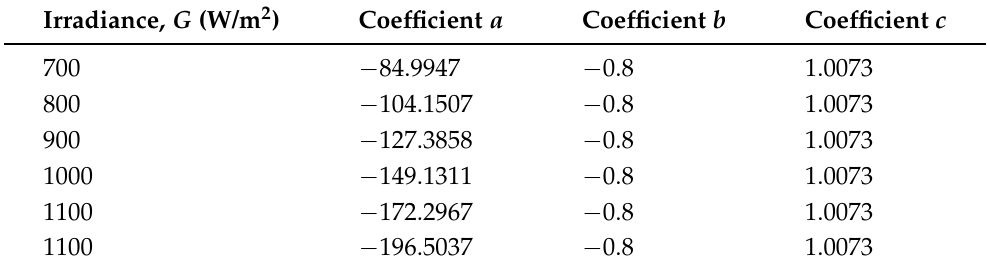
Table 4. Coefficients with different irradiance and on left side operation.